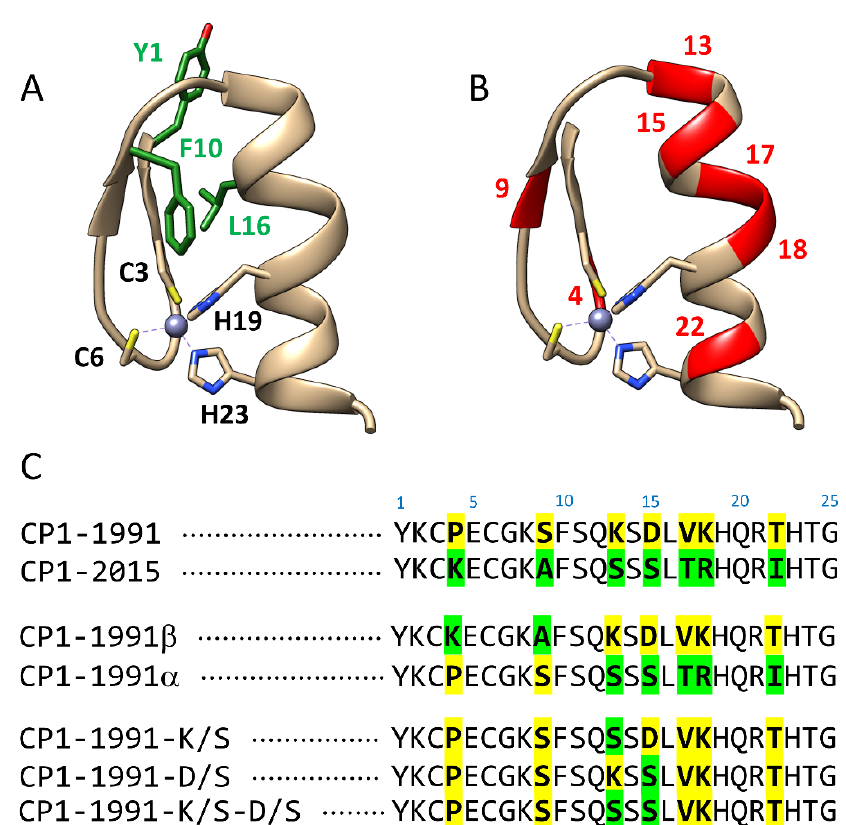
Figure 1. Structure and sequences of zinc finger peptides obtained and examined in this work. ( A ) Structural representation of consensus zinc finger peptide CP1 with an indication of Zn(II) binding (C3, C6, H19, and H23) and hydrophobic residues (green). Figure prepared using Chimera v. 1.13.1 based on the structure of the second ZF of the designed zinc finger protein (PDB: 1MEY) [17]. ( B ) Variable residues present in both CP peptides are marked in red. ( C ) Sequences of ZF peptides used in this study. Yellow and green colours represent amino acid residues of CP1-1991 and CP1-2015, respectively, located at variable positions.